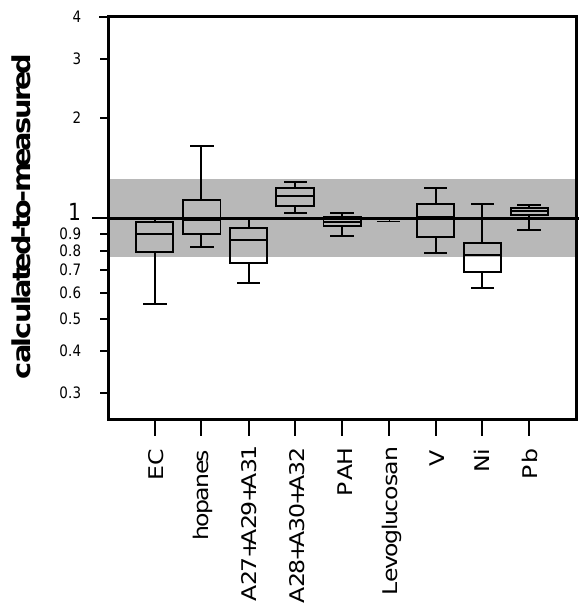
Fig. 5. Model output quality control: comparison between the Fig. 5 measured and the calculated concentration of different markers included in CMB modelling: EC, hopanes (sum of 17 α (H)- trisnorhopane, 17 α (H),21 β (H)-norhopane, 17 α (H),21 β (H)- hopane and 22S,17 α (H), 21 β (H)-homohopane), odd carbon number alkanes (A27+A29+A31), even carbon number alka- nes (A28+A30+A32), PAH (sum of benzo[b,k]fluoranthene, benzo[e]pyrene, indeno[1,2,3-cd]pyrene and benzo[ghi]perylene), levoglucosan, V, Ni and Pb. Black line denotes the 1:1 line and grey area delimit the 0.75–1.25